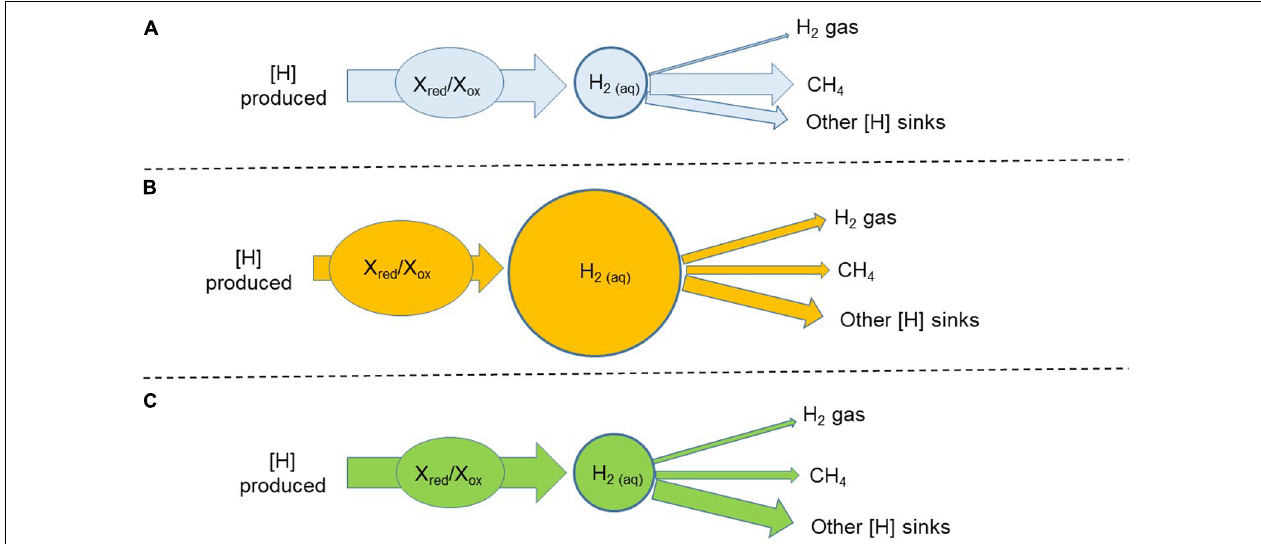
FIGURE 5 | Three hypothetical scenarios of manipulation of metabolic hydrogen ([H]) flows in rumen fermentation: (A) Non-intervened rumen fermentation with functional methanogenesis. Methane (CH 4 ) is the main sink of metabolic hydrogen; (B) Methanogenesis is inhibited with a chemical additive. Part of metabolic hydrogen spared from methane formation is redirected toward alternative sinks that are final fermentation products in the rumen with functional methanogenesis. Redirection of metabolic hydrogen toward alternative sinks is incomplete and the concentration of dissolved dihydrogen increases. The ratio of reduced to oxidized cofactors increases and fermentation, understood as the flow of carbon and the rate of metabolic hydrogen production, is inhibited; (C) A theoretical successful situation in which methanogenesis is inhibited with a chemical additive and an added live hydrogenotrophs redirects a greater proportion of metabolic hydrogen toward alternative sinks potentially beneficial to the host animal. Accumulation of dihydrogen is relieved, cofactors can be re-oxidized as in the rumen with functional methanogenesis, and fermentation is not inhibited.